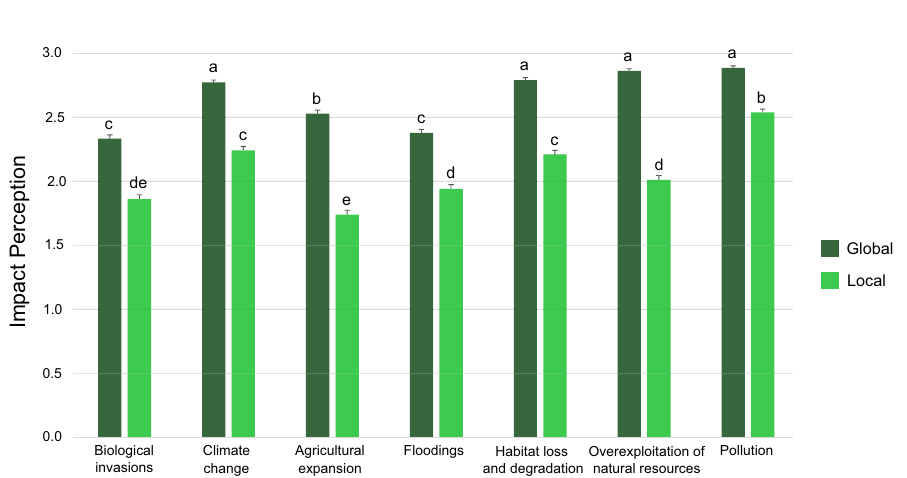
Figure 2. Impact perception of different threats to the environment at local and global scale. Different letters mean a significant difference (Friedman test, P <